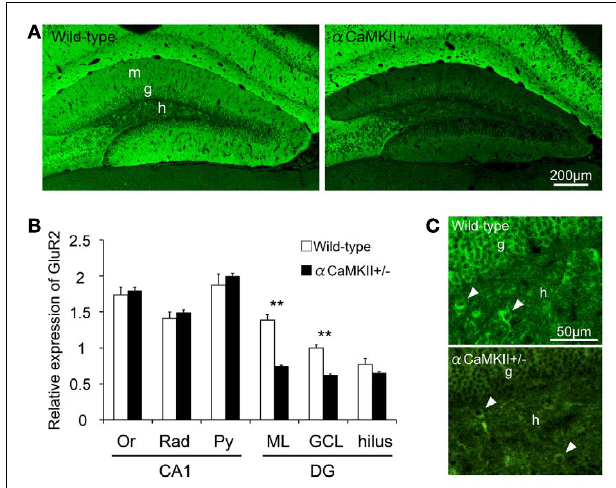
FIGURE 6 | Reduced GluR2 expression in the dentate gyrus of α CaMKII ± mice. (A,B) Immunohistochemical analysis revealed reduced GluR2 expression in the dentate gyrus of the mutant mice. GluR2 immunoreactivity was quantified based on histochemical staining in the hippocampal subfields of α CaMKII ± mice (B) Values represent fluorescence intensity normalized to that in the granule cell layer of wild-type mice and are given as the mean ± SEM of the analysis based on the results of four mice. Asterisks indicate statistically significant differences: ** p < 0.01 (Student’s t -test). (C) GluR2 is expressed in some hilar interneurons of the mutants. Arrowheads indicate examples of GluR2-labeled hilar interneurons. DG, dentate gyrus; GCL, granule cell layer; IGL, internal granule cell layer; ML, molecular layer; Or, oriens layer;